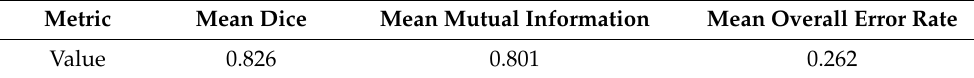
Table 1. Comparison results between ground truth and level set segmentation. Metric Mean Dice Mean Mutual Information Mean Overall Error Rate Value 0.826 0.801